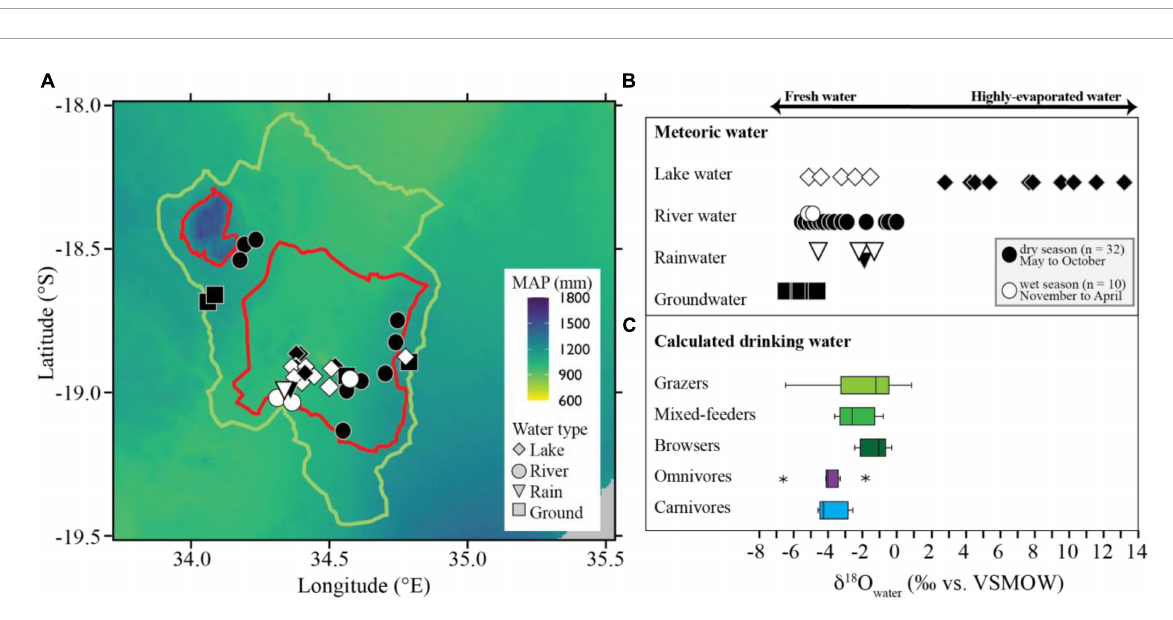
FIGURE6 Map of mean annual precipitation (MAP) for Gorongosa National Park (red line), Buffer Zone (green line), and the surrounding region indicating the locations of water sampling sites included in this study (A) . Mean annual precipitation data were generated using WorldClim version 2.1 bioclimatic variables (1970–2000) at a resolution of ∼ 1 km 2 (Fick and Hijmans, 2017). δ 18 O water values of meteoric water sampled in and around GNP during the dry (open symbols) and wet (closed symbols) seasons from 2016 to 2019 (B) . Colored boxplots show the range of possible drinking water for each dietary group when bioapatite δ 18 O enamel to is converted to δ 18 O water (after Kohn and Cerling, 2002); stars indicate outliers (C)